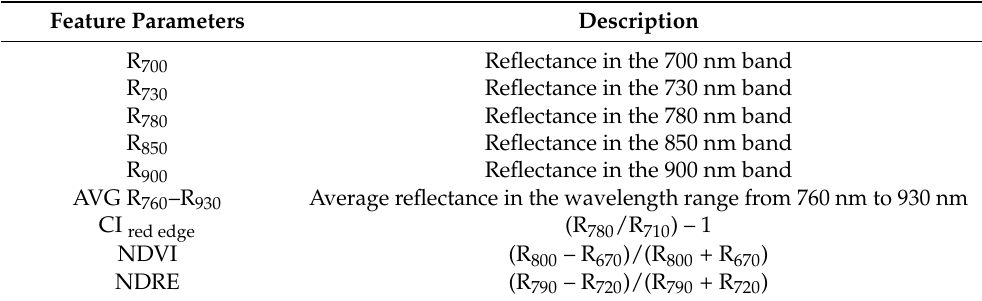
Figure 5. The reflectance of persimmon tree components. Table 1. Selected classification feature